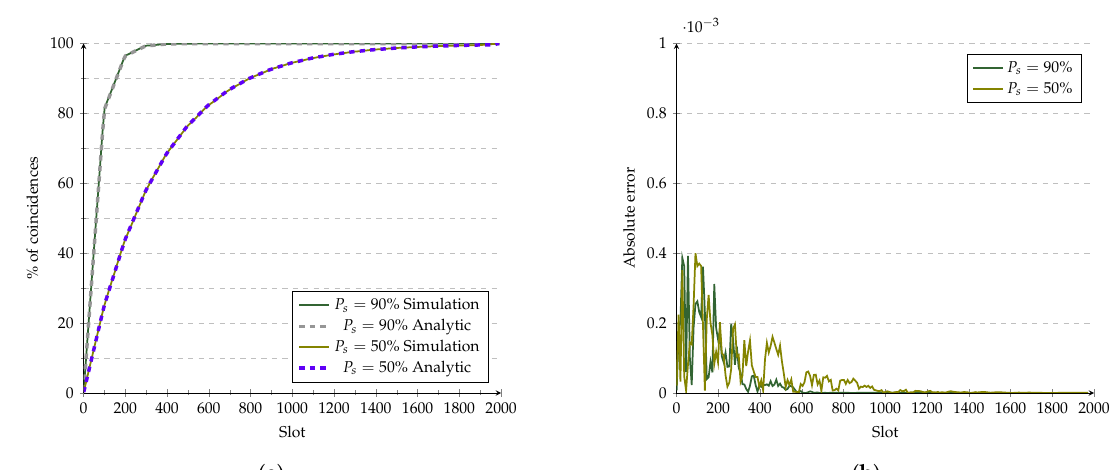
Figure 11. Evaluation of Disco’s analytic model at 10% duty cycle. ( a ) Analytic model vs. simulations. ( b ) Error of the analytic